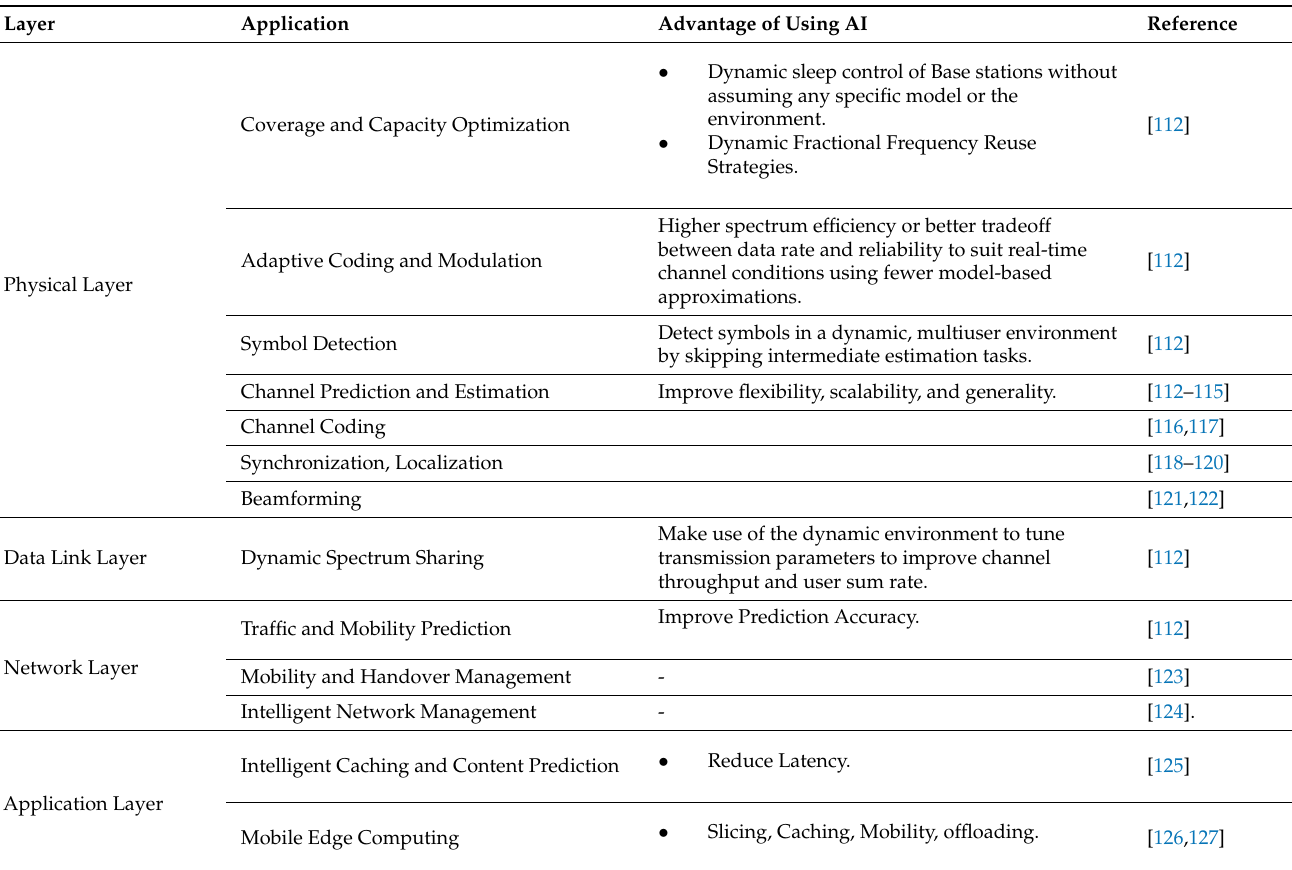
Table 8. Application of AI in different layers of 6G communication networking protocol